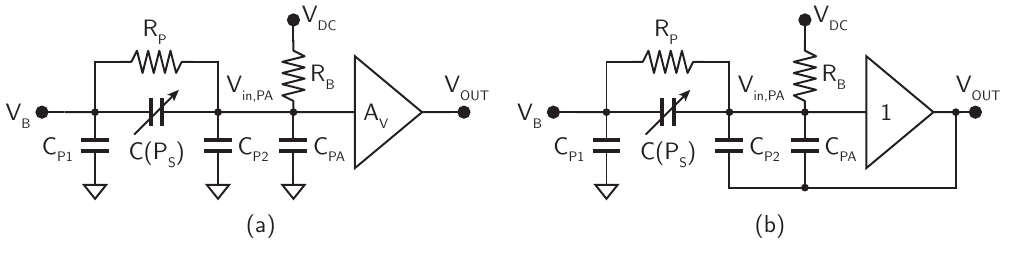
Figure 5. Block diagram of the preamplifier without ( a ) and with ( b ) parasitic capacitance